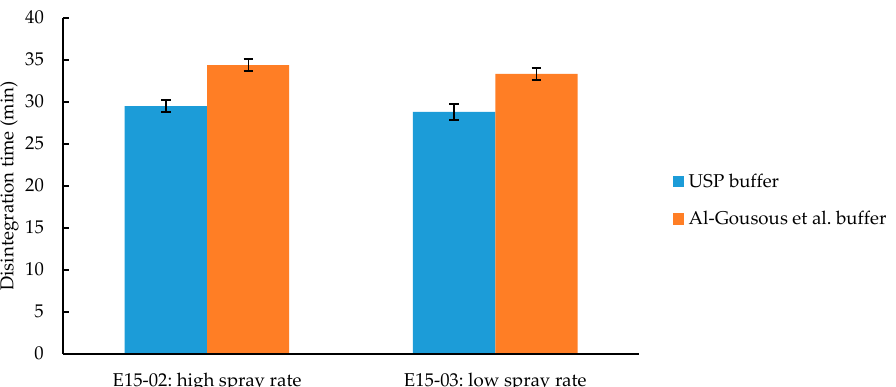
Figure 9. E ff ect of di ff erent coating parameters on the disintegration time. Given are average Figure 9. Effect of different coating parameters on the disintegration time. Given are average disintegration times ± SD; n = 6. E ff ect of disc vs. sinker on the disintegration time. disintegration times ± SD; n = 6. Effect of disc vs. sinker on the disintegration time. 3.3.5. Difference between Disintegration Test Performed with Disc vs. without Disc but with Sinker